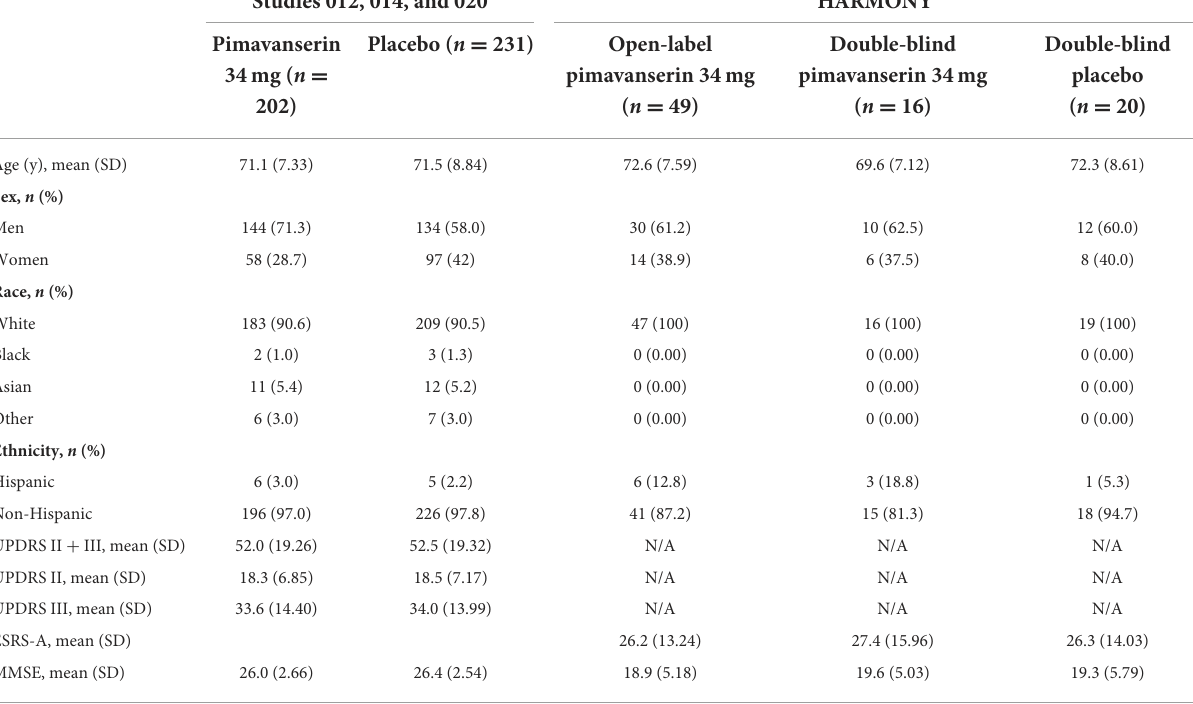
TABLE 1 Baseline characteristics of patients in studies 012, 014, and 020 (pooled) and of patients with PD dementia with psychosis in HARMONY. Studies 012, 014, and 020 HARMONY Pimavanserin Placebo ( n = 231) Open-label Double-blind Double-blind 34mg ( n = pimavanserin 34mg pimavanserin 34mg placebo 202) ( n = 49) ( n = 16) ( n = 20)